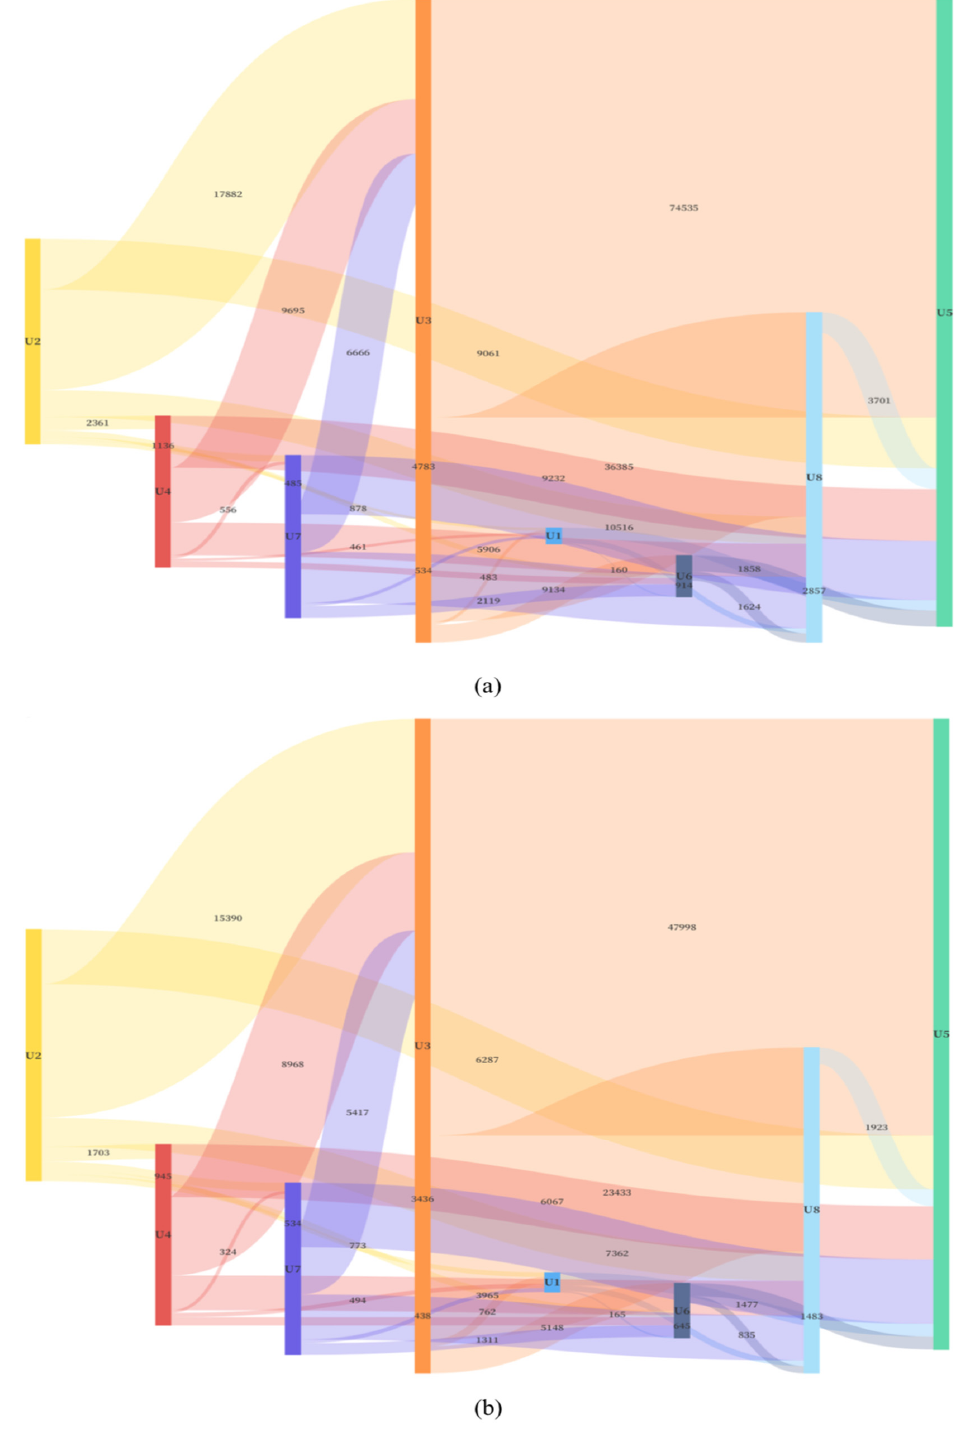
Figure 4. The net flow paths and volumes of energy consumption in different sectors of China (10 4 tce). Note: ( a ) Shows the net flow of energy consumption in 2018. ( b ) Shows the average of the net flow of energy consumption between 2002 and 2018. Colors indicate the eight different sectors. Energy consumption flows from the sectors on the left to the sectors on the right. The width of the line represents the volumes of energy consumption net flow, and the specific volumes are shown in the middle.